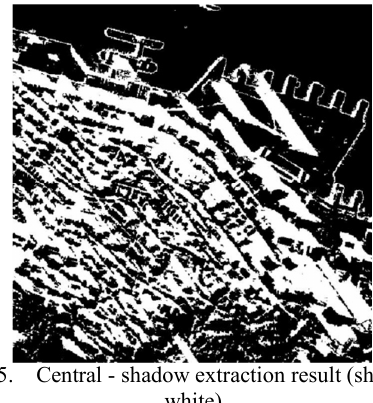
Figure 5. Central - shadow extraction result (shadows in white)